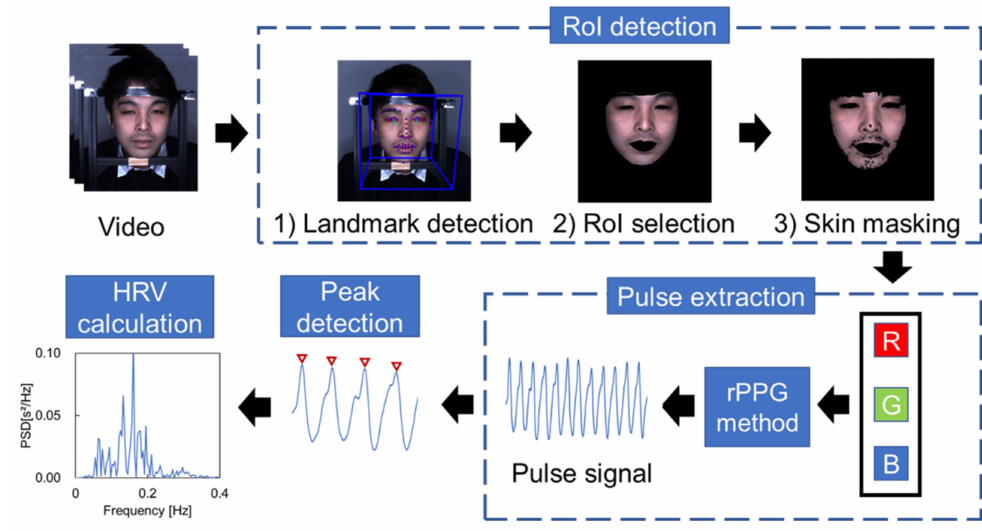
Figure 2. Overview of the processing